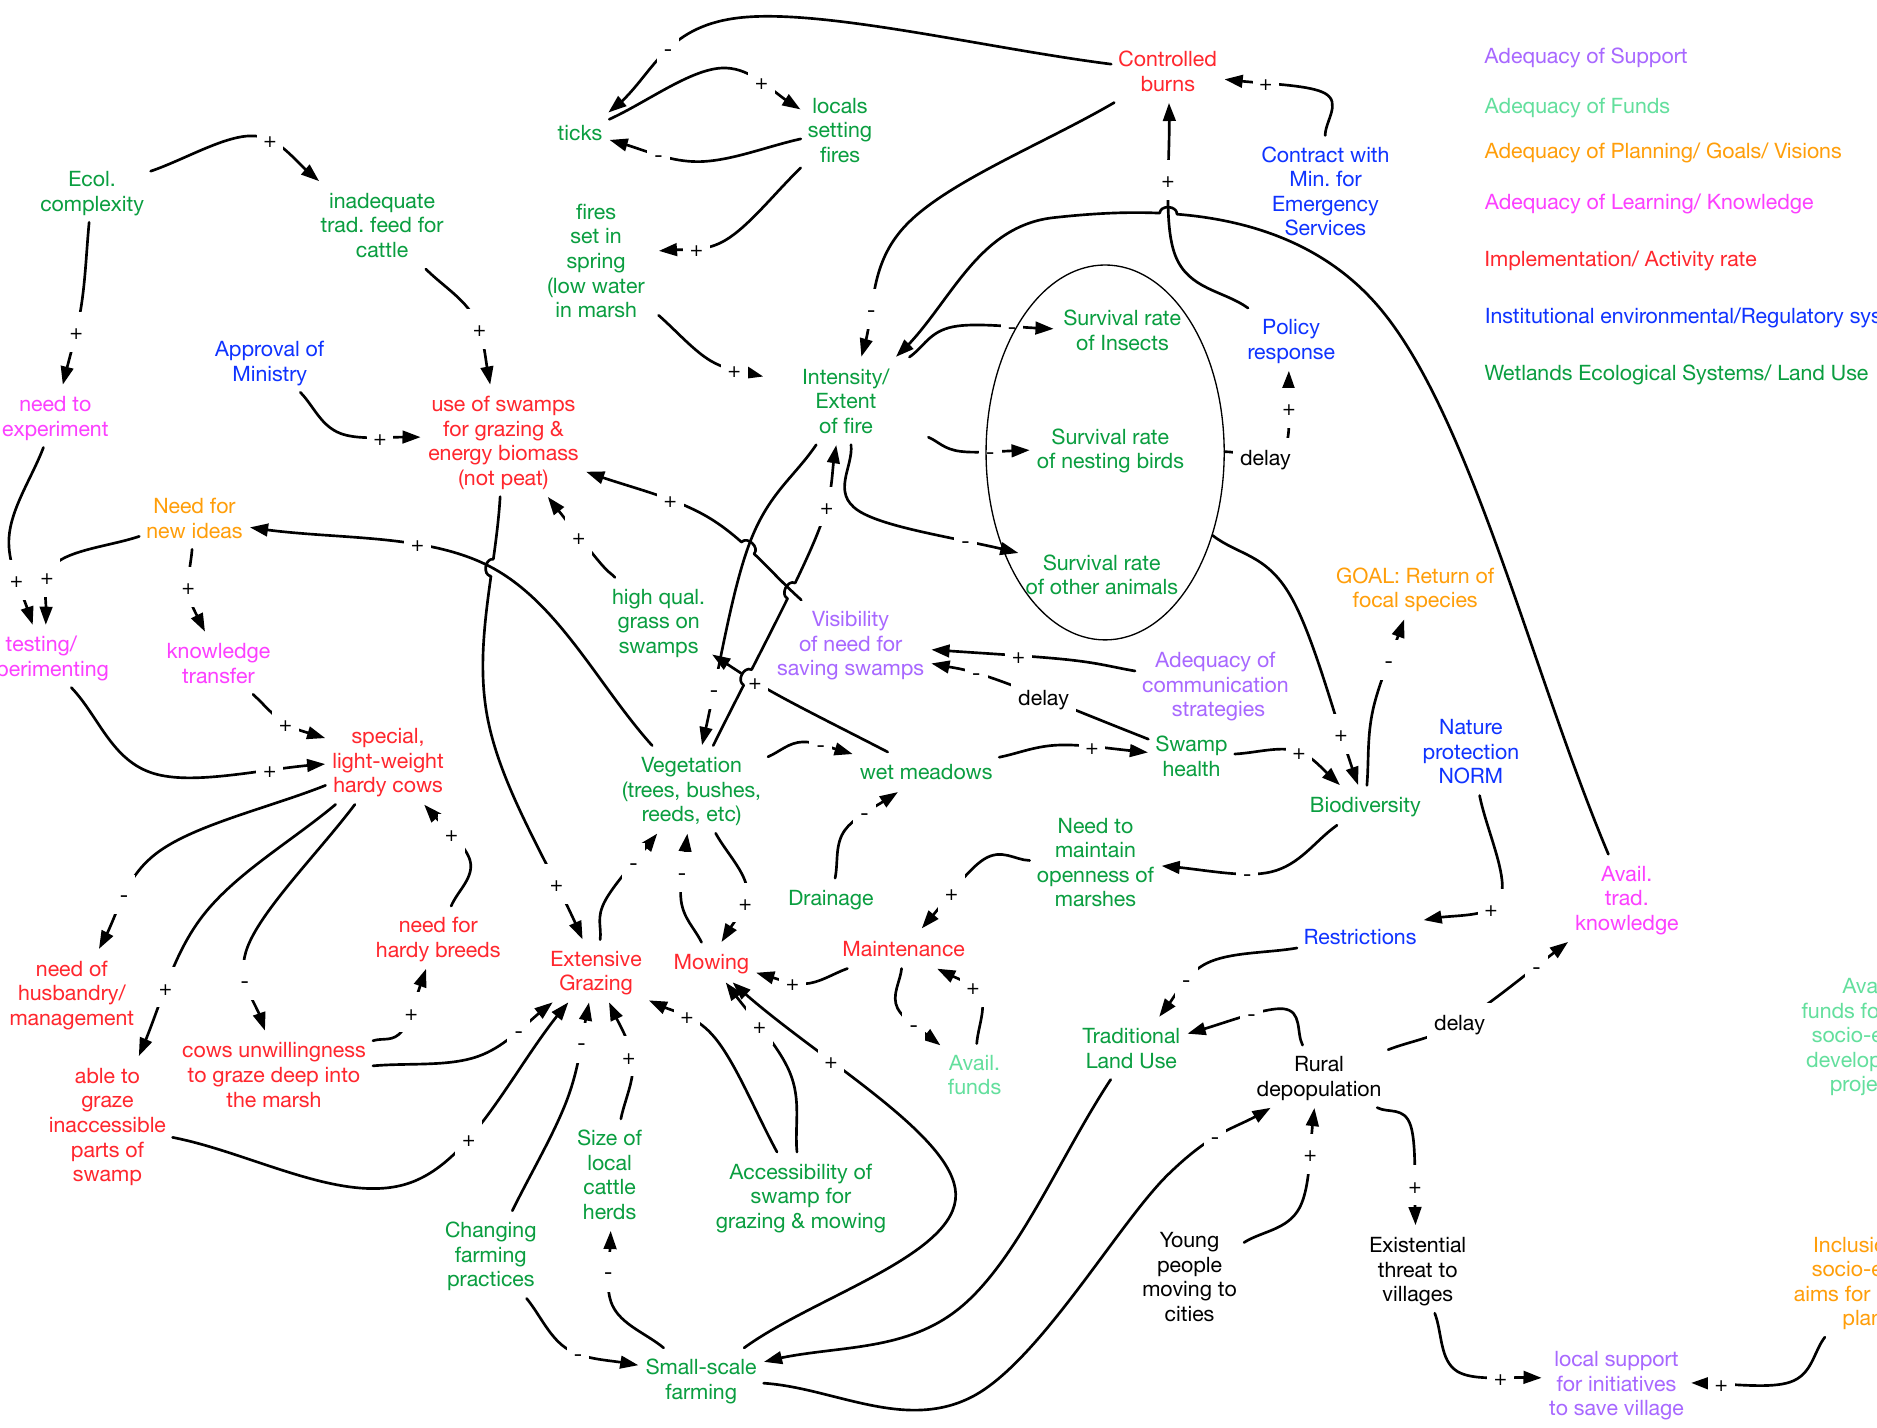
Figure A2:10. Case Birds, Theme: Ecological system, land